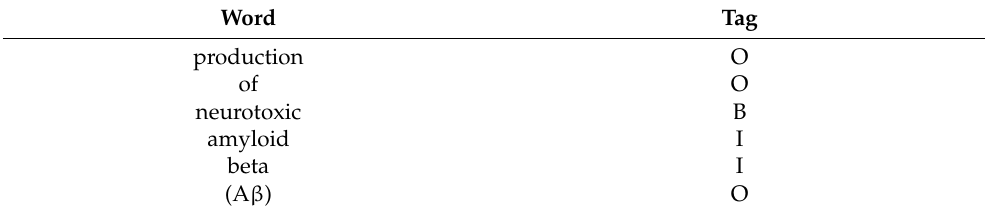
Table 3. Dataset